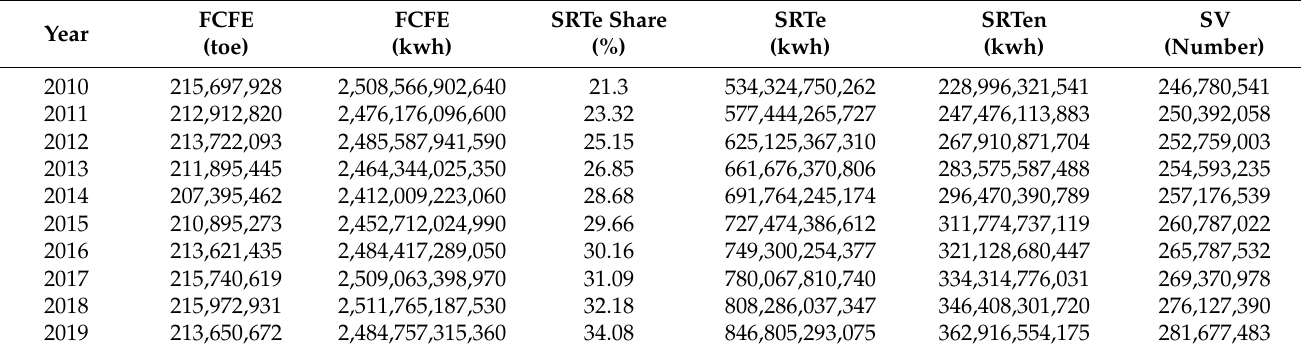
Table A1. Historical trends of selected data.